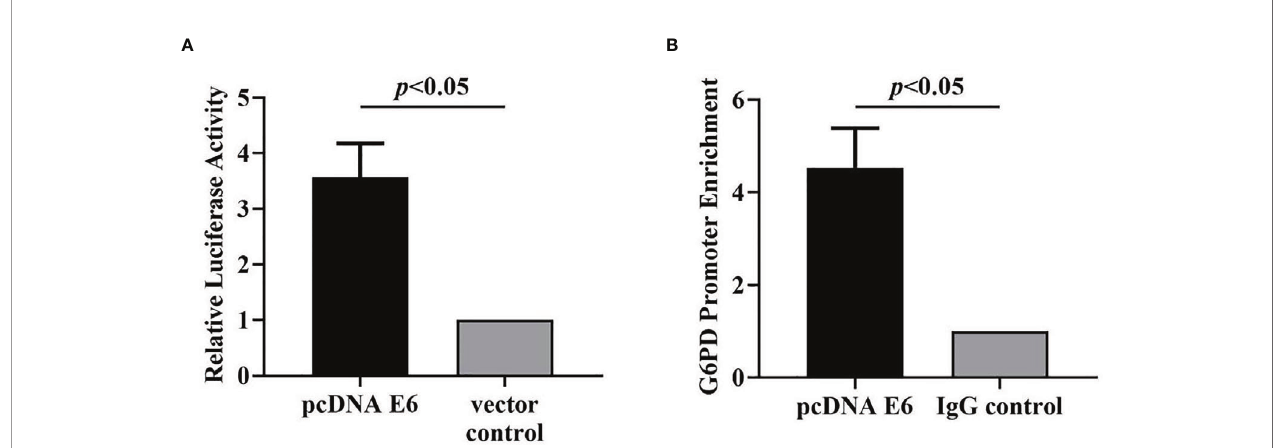
FIGURE 11 | HPV16 E6 activates G6PD transcription and binds directly to the G6PD promoter. The luciferase activity (A) and the enrichment of G6PD promoter (B) in HeLa cells statistically increased after pcDNA E6 treatment, compared with the control groups, respectively. Data are presented as means ± SD (n =